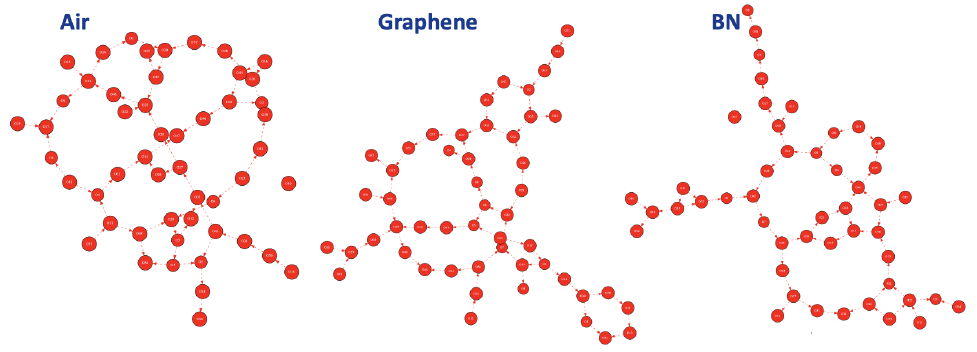
Figure 7. Illustration of a 2D-MolGraph applied to condensed phase systems, for each hydropho- bic aqueous interface investigated here: air/liquid water ( left ), graphene/liquid water ( middle ), BN/liquid water ( right ). Only the water molecules located in the BIL (Binding Interfacial Layer; see definitions in [17]) are taken into account for the 2D-MolGraph analysis ( ∼ 48 water molecules on average). Vertices of the graph represent the oxygen atoms of the water molecules (red); the dashed red arcs represent the H-bonds between two water molecules oriented from donor to acceptor.